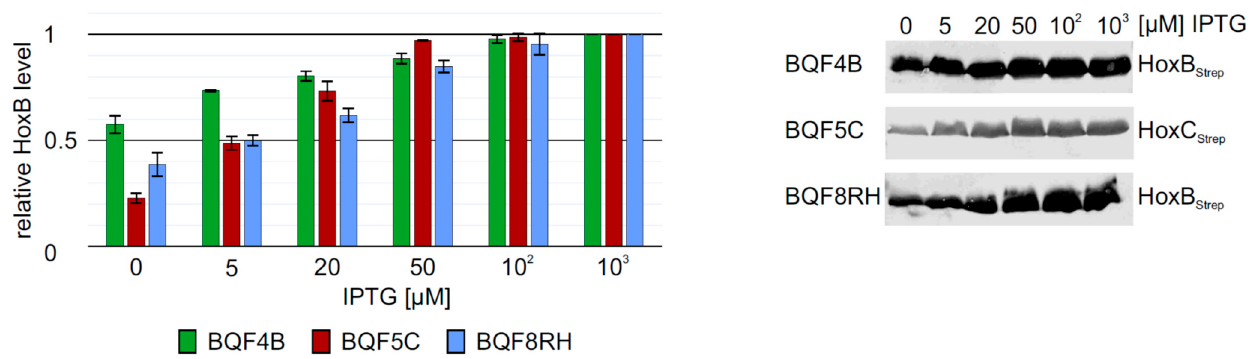
Figure 2. Heterologous overproduction of Hox proteins from plasmids pQF4, pQF5, or pQF8 in E. coli BL21-Gold (BQF4B, BQF5C, or BQF8RH). Cells were cultivated in TB medium in deep-well plates at 37 ◦ C as described in Materials and Methods. RH production was induced with varying IPTG concentrations. HoxB production was analyzed by Western blotting (normalized to OD 600 ) with Strep-tag antibodies (right part) and subsequent quantification of the bands using ImageJ. For each strain, protein amounts were calculated relative to the amount of protein at a maximum inducer concentration of 1 mM IPTG.